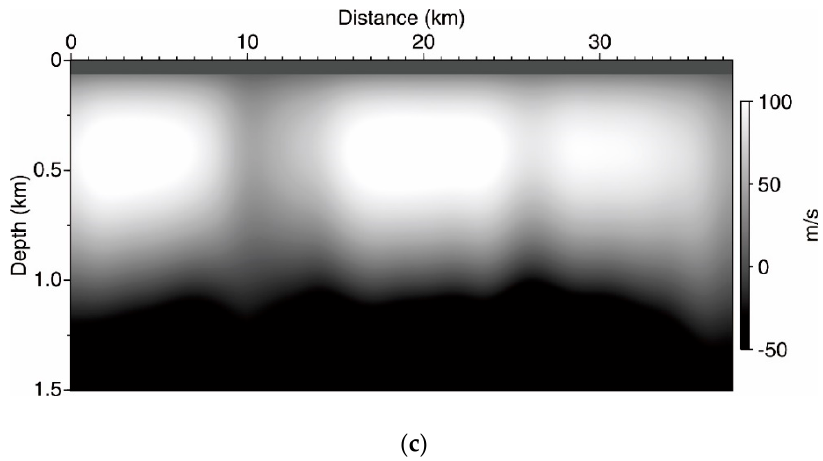
Figure 6. ( a ) Initial depth ‐ domain interval velocity for MVA obtained by converting the time ‐ domain RMS velocity. ( b ) Final updated depth ‐ domain interval velocity after MVA at the 3rd iteration. ( c ) Difference between ( a ) and ( b ).